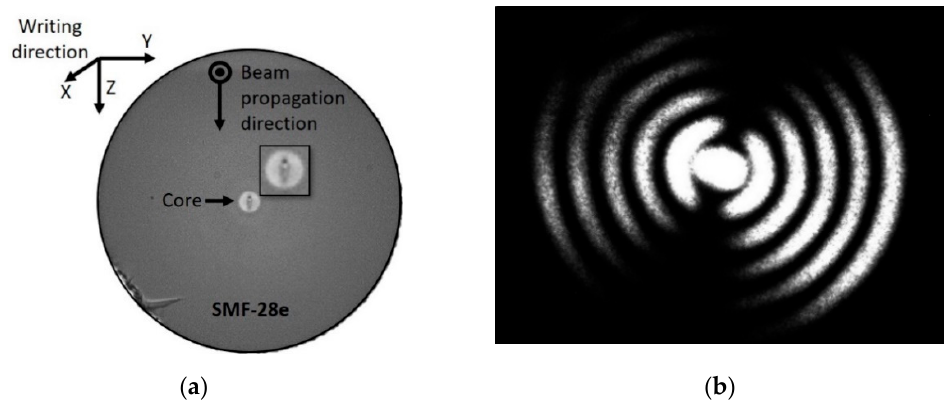
Figure 4. Fs laser inscribed LPFG in the SMF-28e fiber with a 8.2 µm core: ( a ) Optical microscope view of the cross-section; ( b ) Near-field intensity distribution of the cladding mode LP 1,6 at 1592.7 nm (grating period of 390 µm).